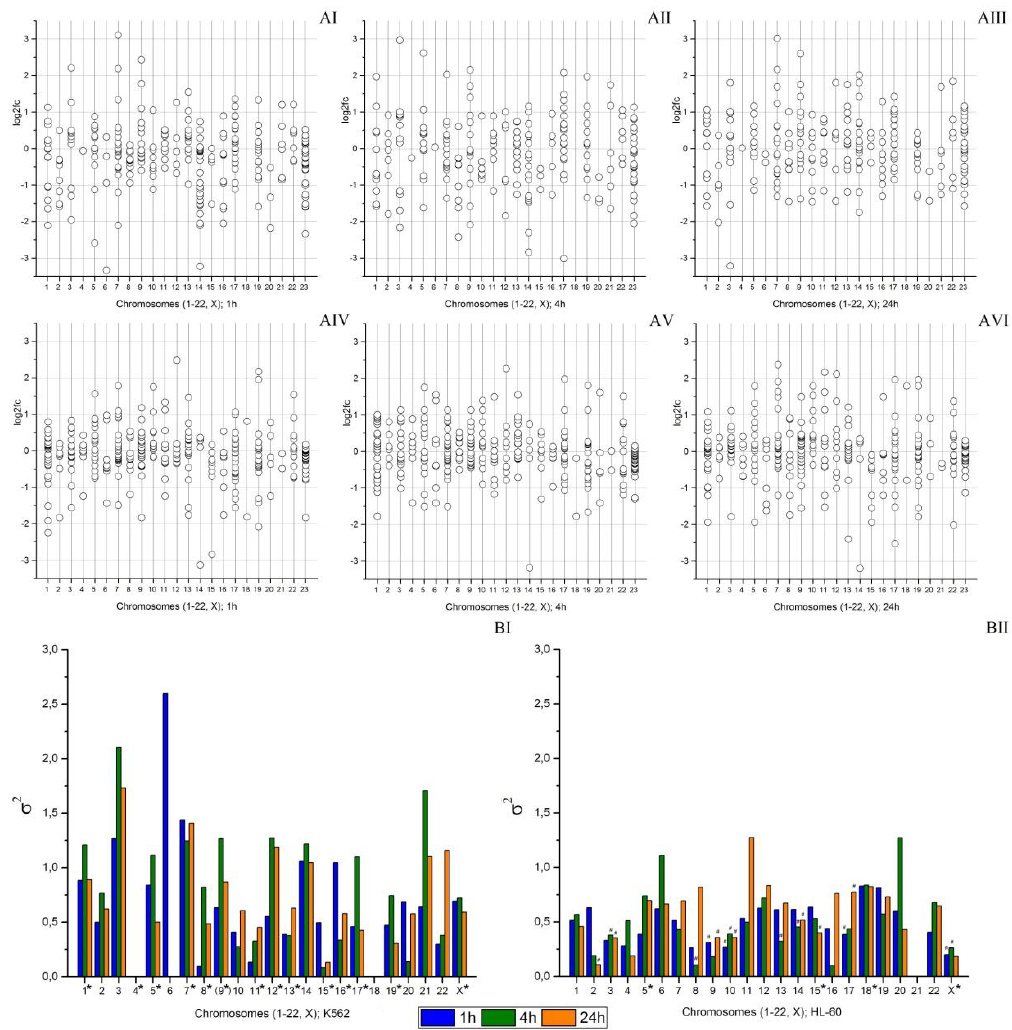
Figure 4. Analysis of microRNA expression dynamics depending on chromosome localization. ( A ) MicroRNA expression changes after radiation exposure at the dose of 4 Gy compared to control: AI —in the K562 cell line 1 h after irradiation; AII —in the K562 cell line 4 h after irradiation; AIII —in the K562 cell line 24 h after irradiation; AIV —in the HL-60 cell line 1 h after irradiation; AV —in the HL-60 cell line 4 h after irradiation; and AVI —in the HL-60 cell line 24 h after irradiation. ( B ) Dispersion of the log2fc values of microRNAs located in the chromosomes of the K562 and HL-60 cell lines: BI—the K562 cell line; BII—the HL-60 cell line. *—chromosomes with abnormalities (excluding translocations). (9*)—the ninth pair of chromosomes is absent in the K562 cell line but is part of the marker chromosomes. #—statistically significant difference from the K562 cell line, p < 0.05.